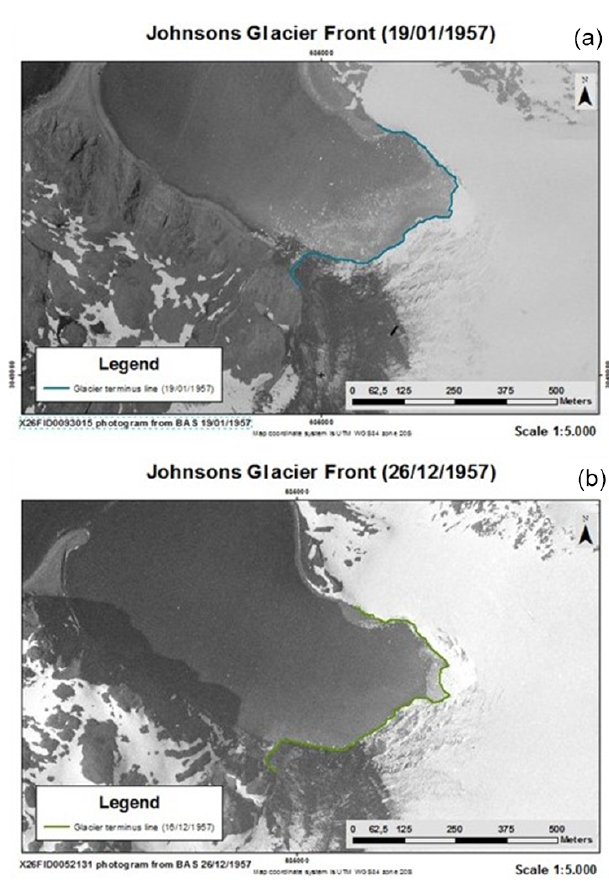
Figure 8. (a) Position of Johnsons Glacier calving front at the be- ginning of 1957 (blue line). The base map corresponds to the BAS photogrammetric flight of date 19 January 1957. This flight was not completed, and it can only be used for planimetric measurements at sea level. (b) Position of Johnsons Glacier calving front at the end of 1957 (green line). The base map corresponds to the BAS photogrammetric flight of date 26 December 1957. The scale of the figure does not match with the numerical map scale